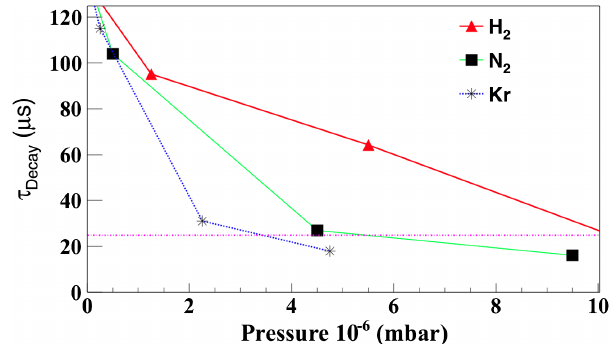
FIG. 20. Measured beam size decay time of the partial pressures for H 2 , Kr, and N 2 . The dotted line shows the desired stabilization time of 25 μ